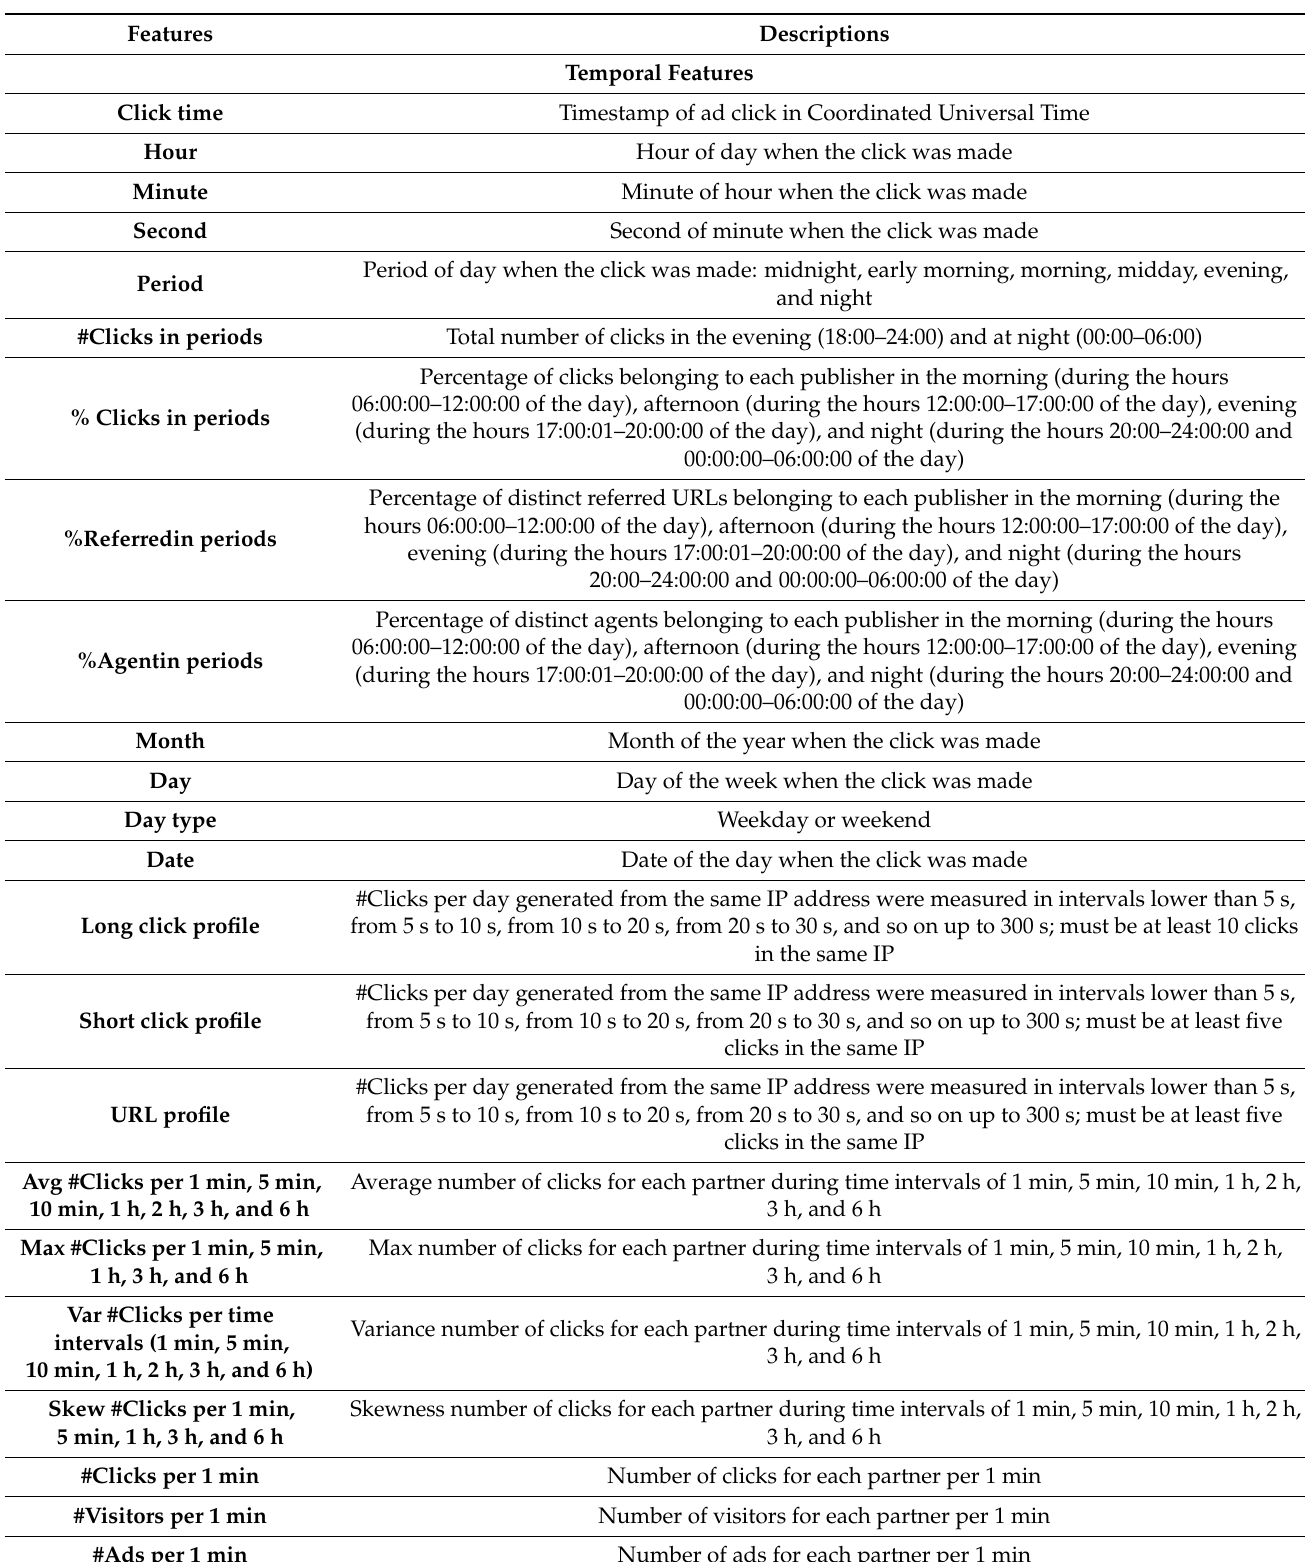
Table A2. A brief description of all features used in previous studies (included in the literature